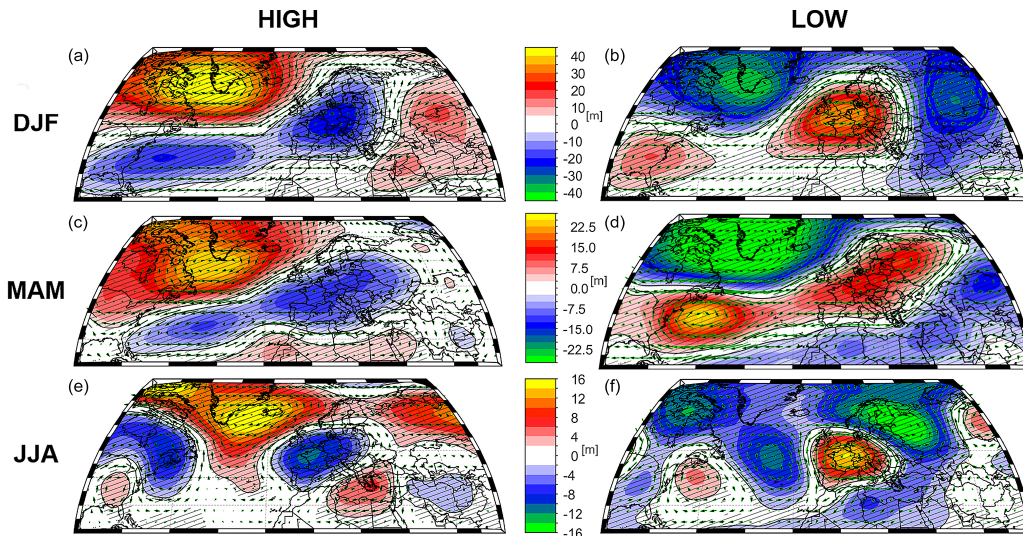
Figure 5. Composite maps (high and low) for Z500 related to the first δ 18 O component for the DJF, MAM, and JJA seasons. Panels (a) and (b) show the characteristics of the climate in DJF, panels (c) and (d) show the characteristics of the climate in MAM, and panels (e) and (f) show the characteristics of the climate in JJA. The results for maxima (a, c, e) and minima (b, d, f) events of PC1 are also given. The Z500 maps show similar characteristics in winter and spring, whereas a pressure regime is directly located over central Europe in summer. The Z500 dataset from 20CRv2c (Compo et al., 2011) is used in this figure for the period from 1901 to 2005. Furthermore, the significance is shown using a black contour